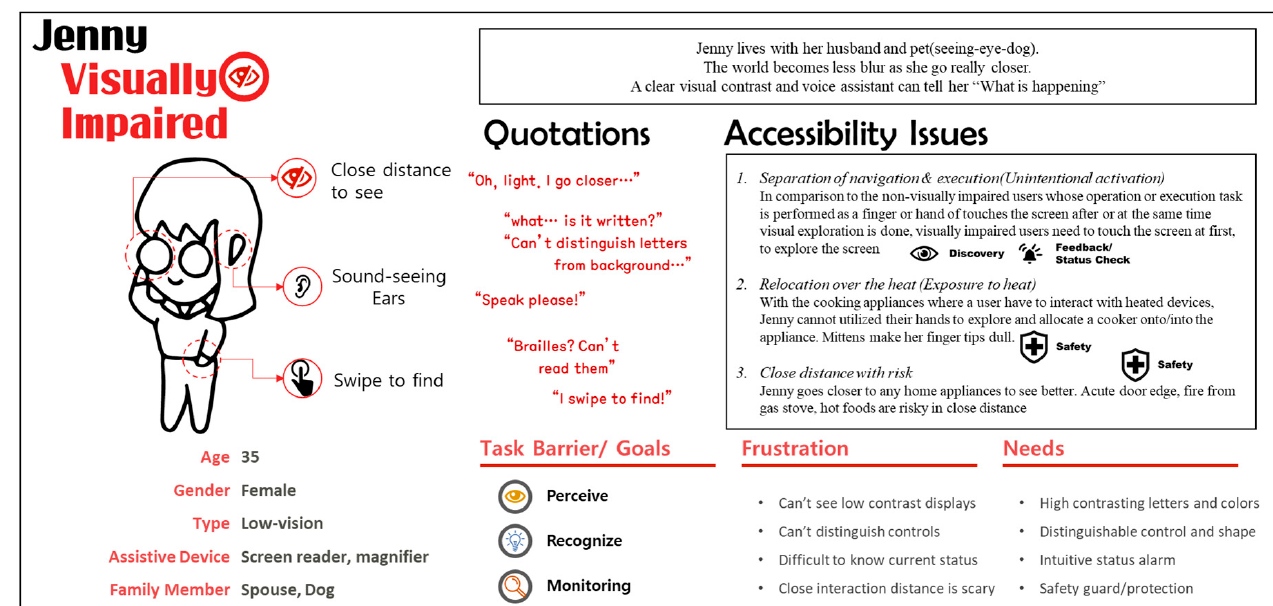
Figure A1. Persona card of Suzy, the blind persona.